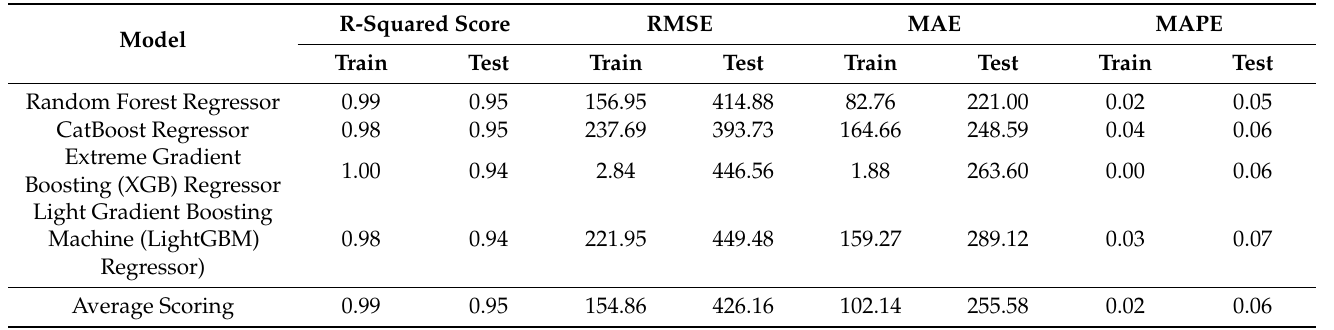
Table 8. Comparative performance